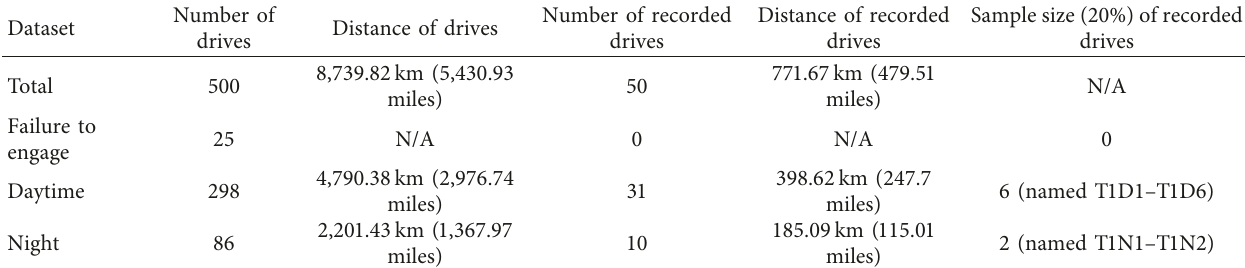
Table 4: Data used in Test 1.